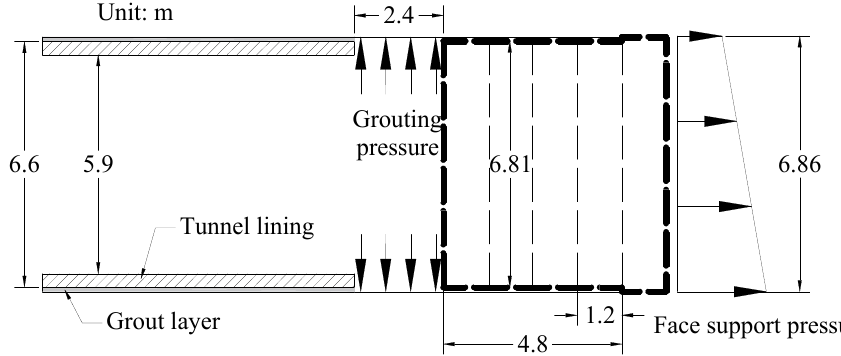
Figure 5. Schematic diagram of shield tunnel excavation.